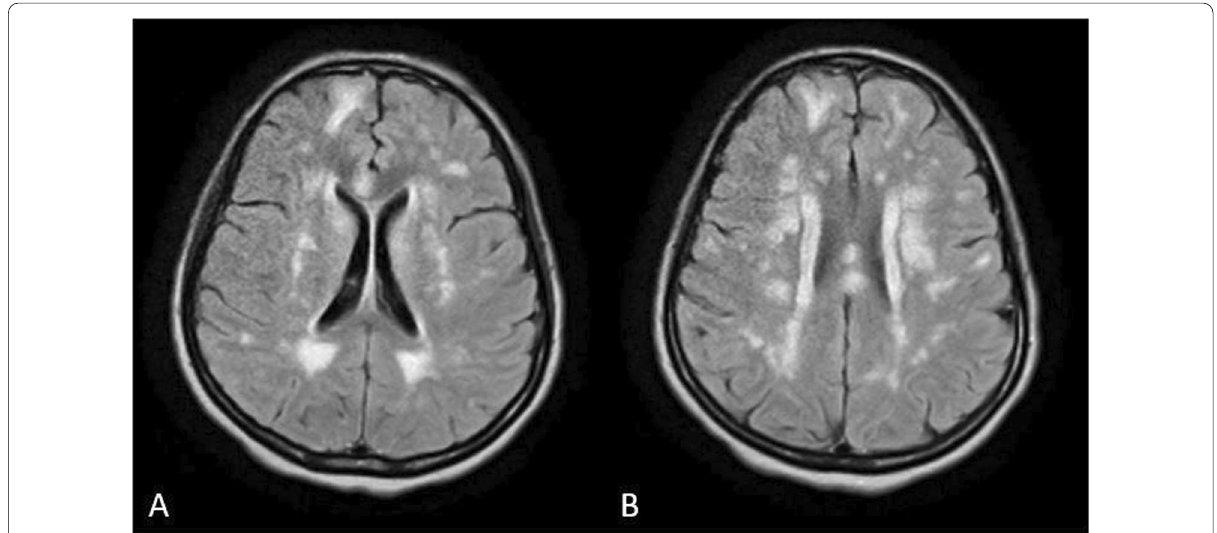
Fig. 4 A and B Showing FLAIR image with multiple hyperintense signal changes involving subcortical white matter of bilateral frontal lobes, bilateral periventricular white matter, bilateral corona radiata and corpus callosum